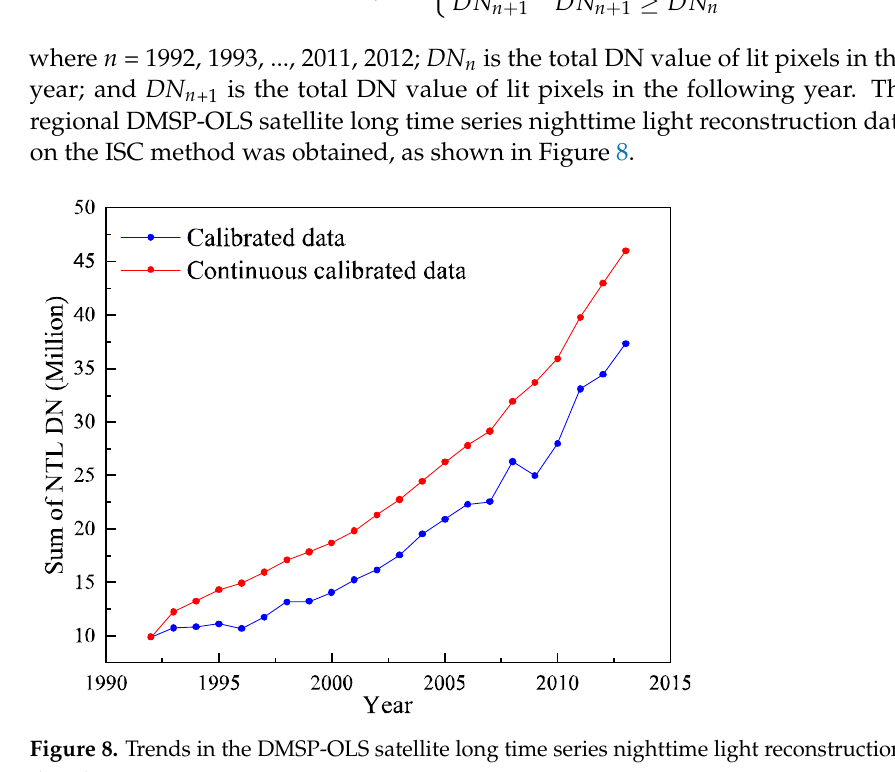
Figure 8. Trends in the DMSP-OLS satellite long time series nighttime light reconstruction dataset for the Chinese region.